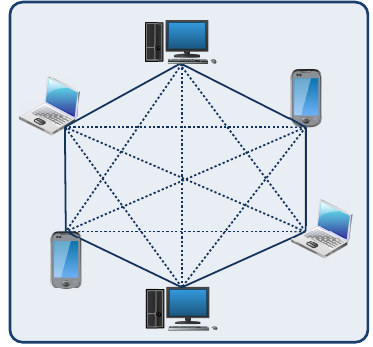
Figure 5. Public blockchain [79].